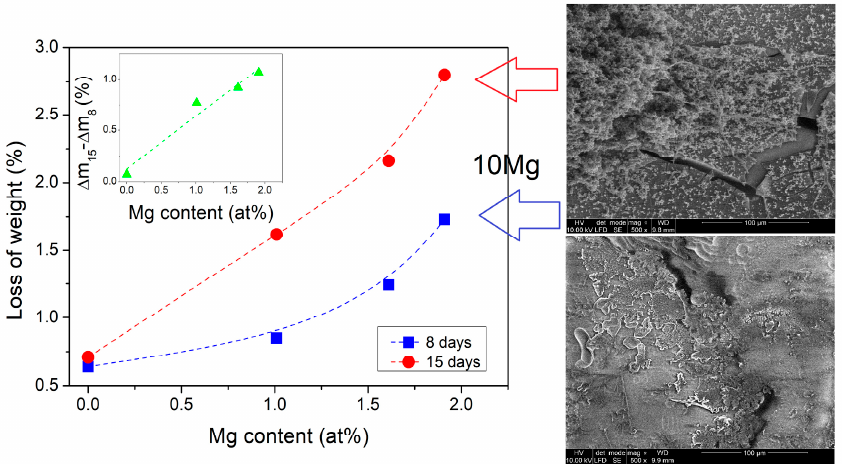
Figure 6. The results of the biosolubility test for all samples after 8 and 15 days of incubation in PBS as a function of Mg content. Figure insert shows the effect of Mg content on the difference between loss of weight after 15 and 8 days. On the right, the SEM micrographs of the 10Mg glass are shown, correlated by arrows with specific weight loss.